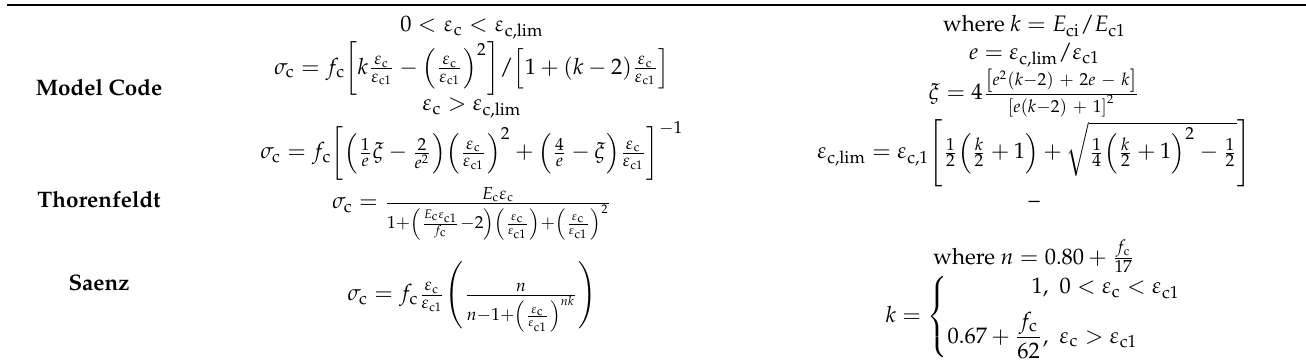
Table 3. Three commonly used constitutive models for concrete in compression.